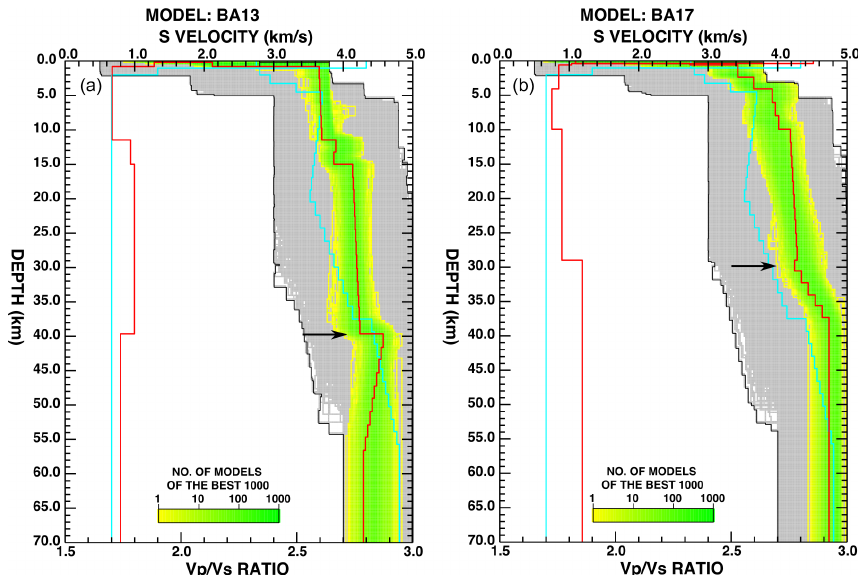
Figure 9. Seismic velocity models for temporary stations BA13 (a) and BA17 (b) obtained from the neighbourhood algorithm. See Figs. S6– S9 in the Supplement for all receiver function inversion results for the temporary BASS network, including waveform fits (Supplement Fig. S7 includes the waveform fit for stations BA13 and BA17).